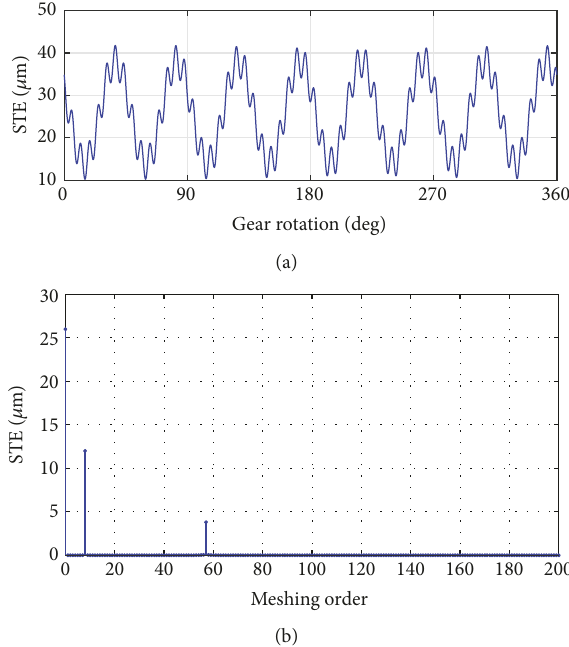
Figure 14: Example of STE curve obtained for STEh = 10 𝜇 m and STEm = 3.8 𝜇 m. STE curve (a) and the results of an FFT analysis in the angle domain